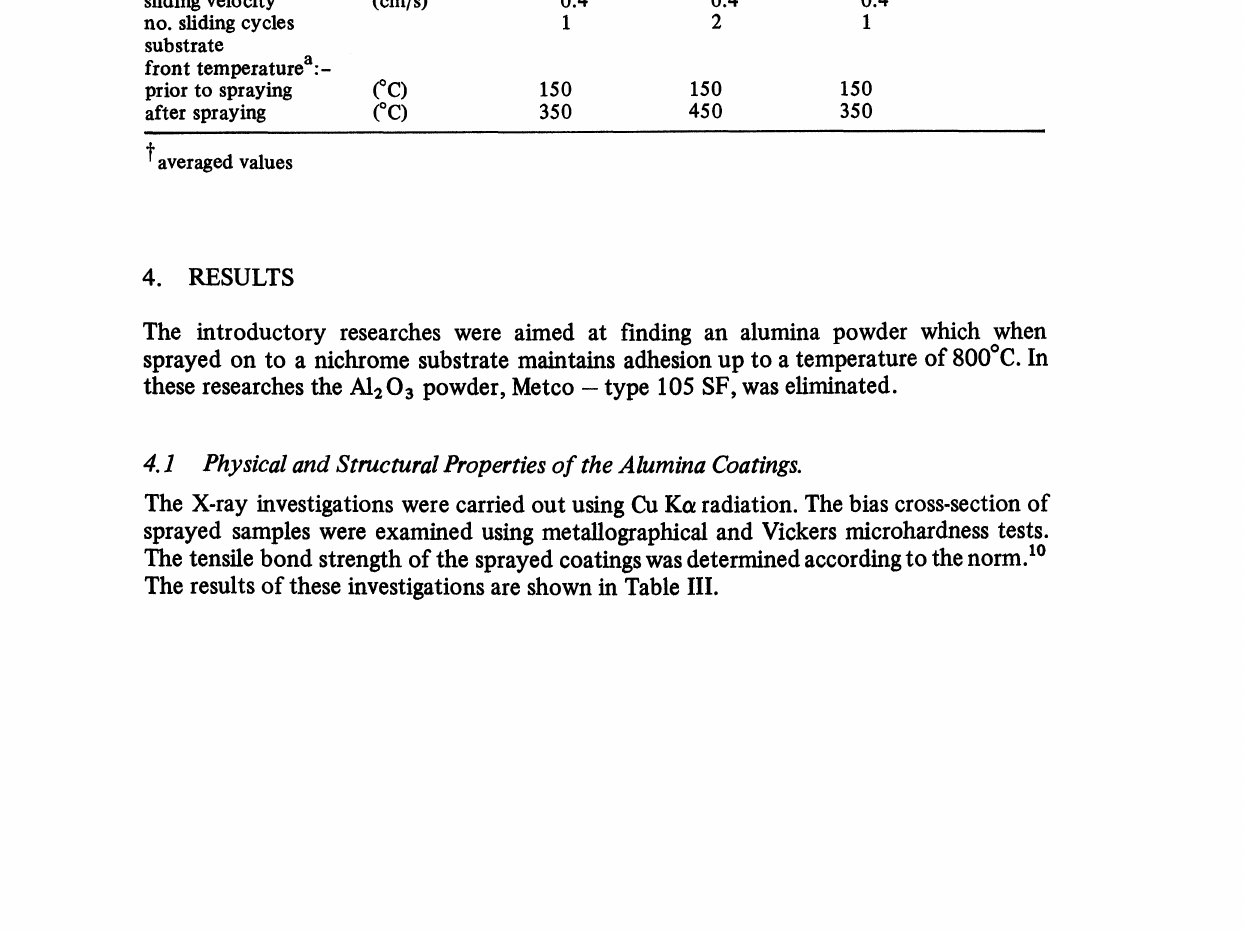
FIGURE 3 Suction cup scheme, metal plate for spraying, 2 Ni NiCr thermocouple, 3 vacuum pump, 4 temperature